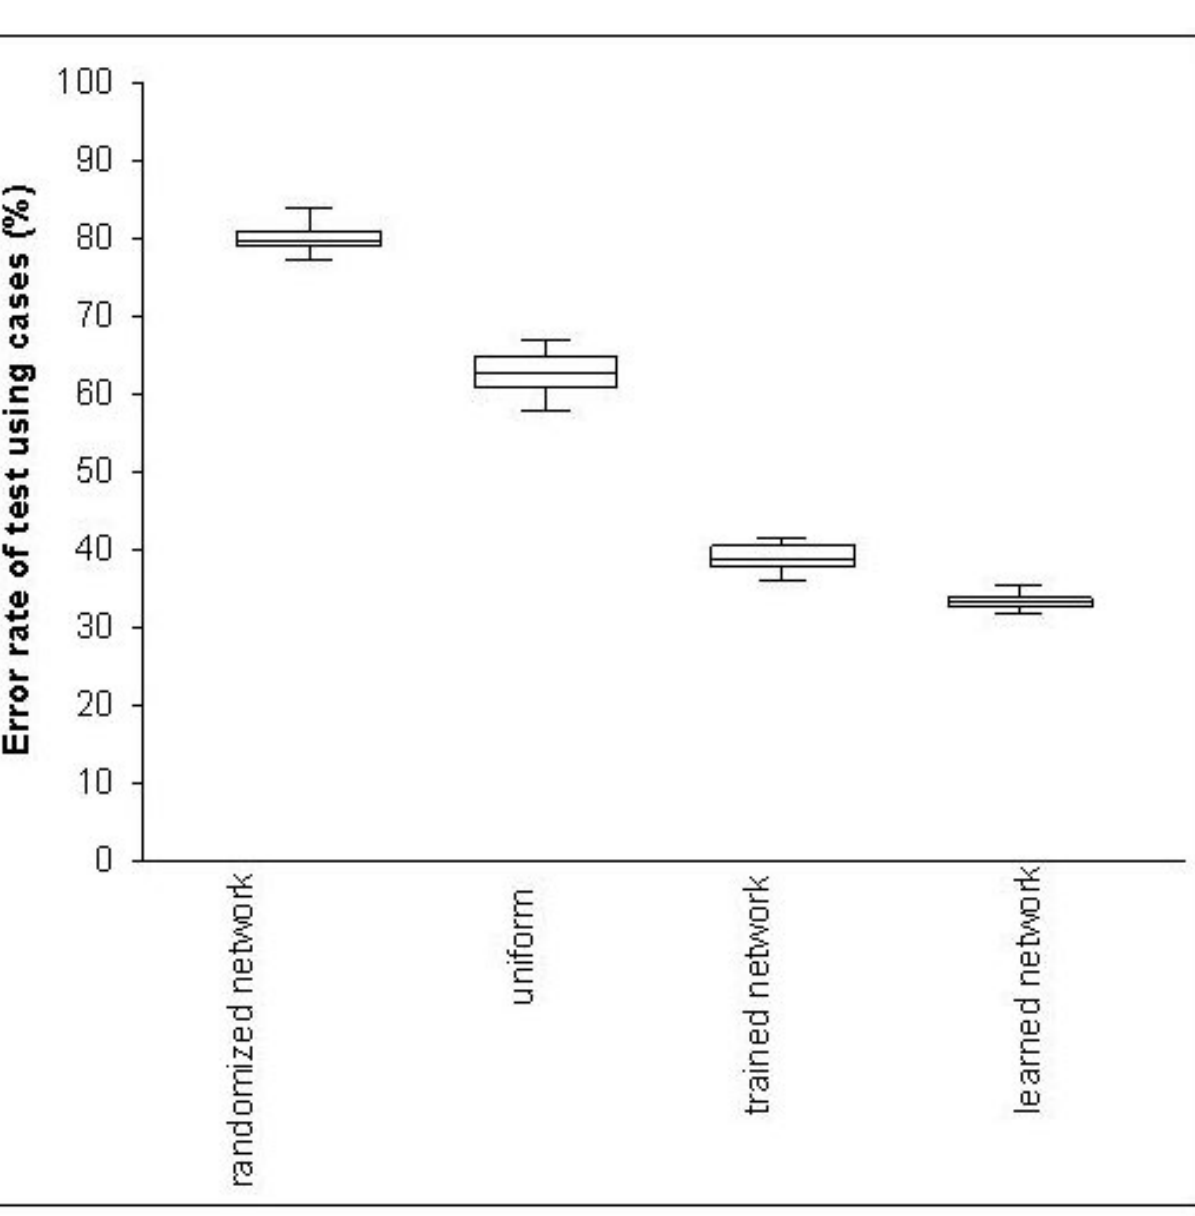
Fig. 5. Boxplots of mean error rate of the test using